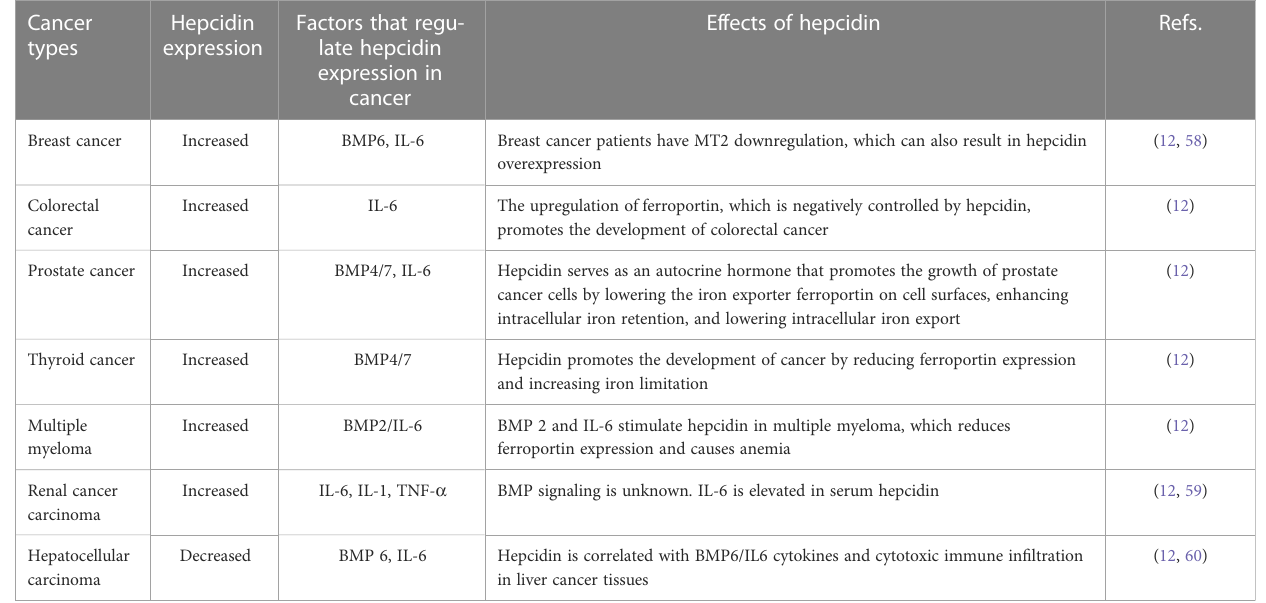
TABLE 2 Hepcidin role in cancer